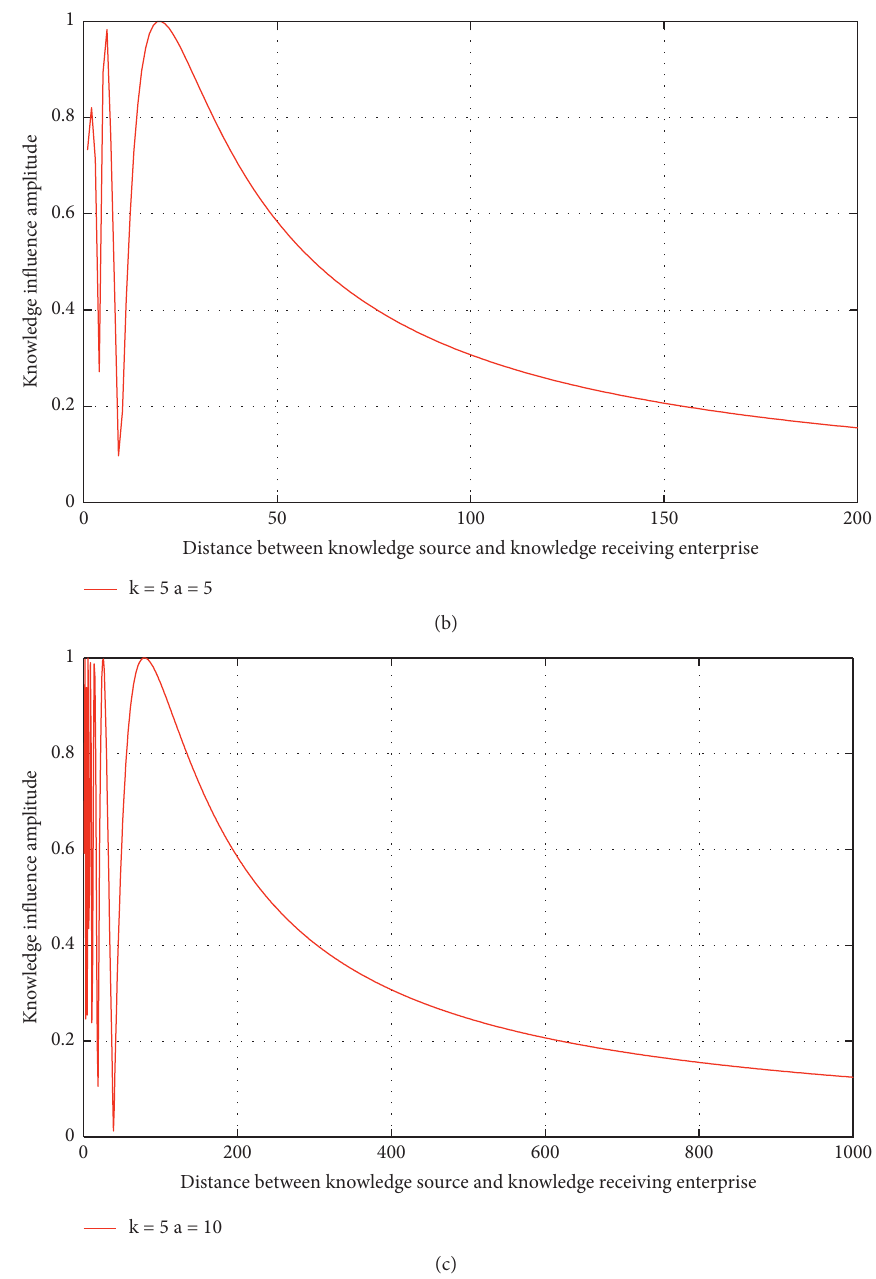
Figure 12: Distributions of the influence amplitude in the knowledge field when k � 5 and a � 2 , 5 ,